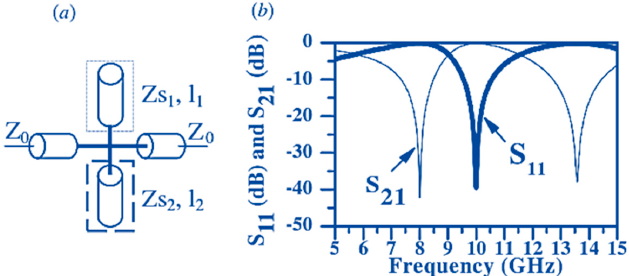
Figure 7. First ‐ order dual ‐ behavior resonator (DBR) band ‐ pass filter (BPF): ( a ) design and ( b ) reflection ( S 11 ) and transmission ( S 21 ) parameters (from [29]; copyright © 2008; redesigned with permission).